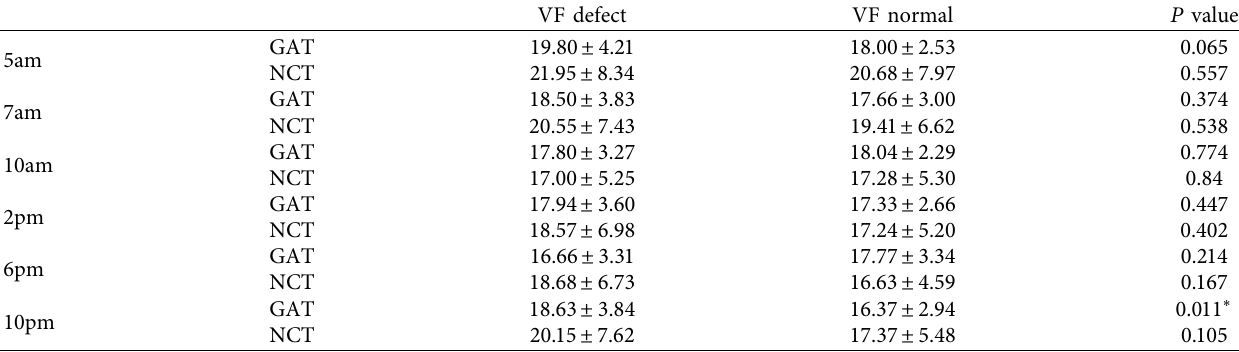
Table 2: IOP measured by the two tonometers at different time points between the groups with and without visual field defect.